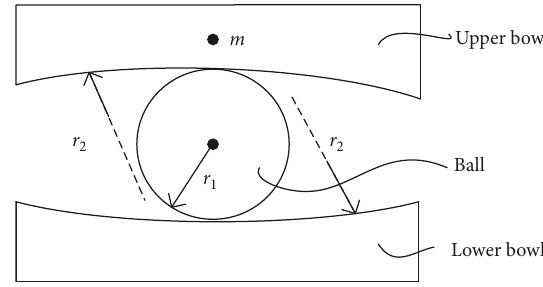
Figure 1: Elastic ball placed between two elastic bowls.